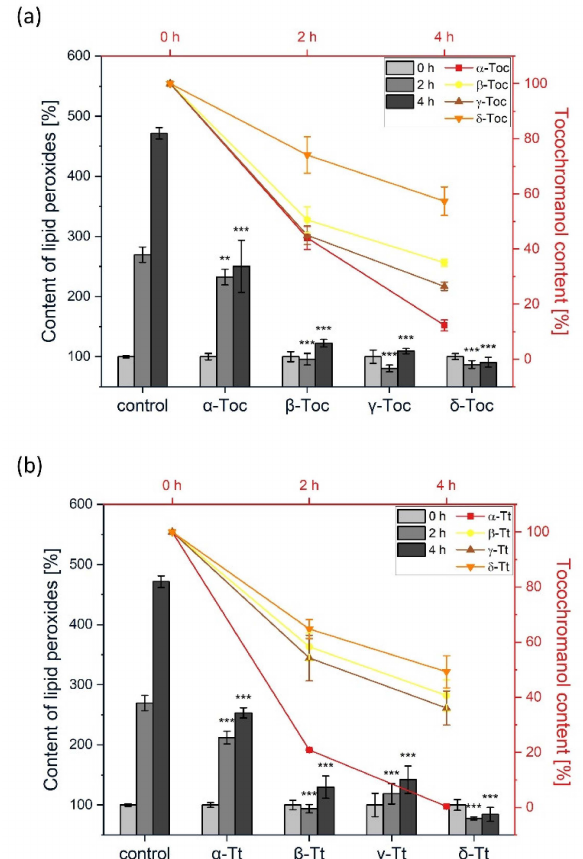
Figure 2. ( a ) The effect of Tocs on the rate of the formation of lipid peroxide in plant lipid liposomes initiated by AMVN ( bars ). Time-course of Tocs level during the peroxidation reaction (lines ). The reaction was performed at 37 ◦ C. ( b ) The effect of Tts on the rate of the formation of lipid peroxides in plant lipid liposomes initiated by AMVN ( bars ). Time-course of Tts decay during the peroxidation reaction ( lines ). The reactions were conducted at 37 ◦ C. The data are means SEM ( n = 3). Asterisks ± indicate statistically significant differences compared with control at corresponding time point (** p < 0.01, *** p < 0.001; one-way ANOVA followed by Duncan’s post hoc test).